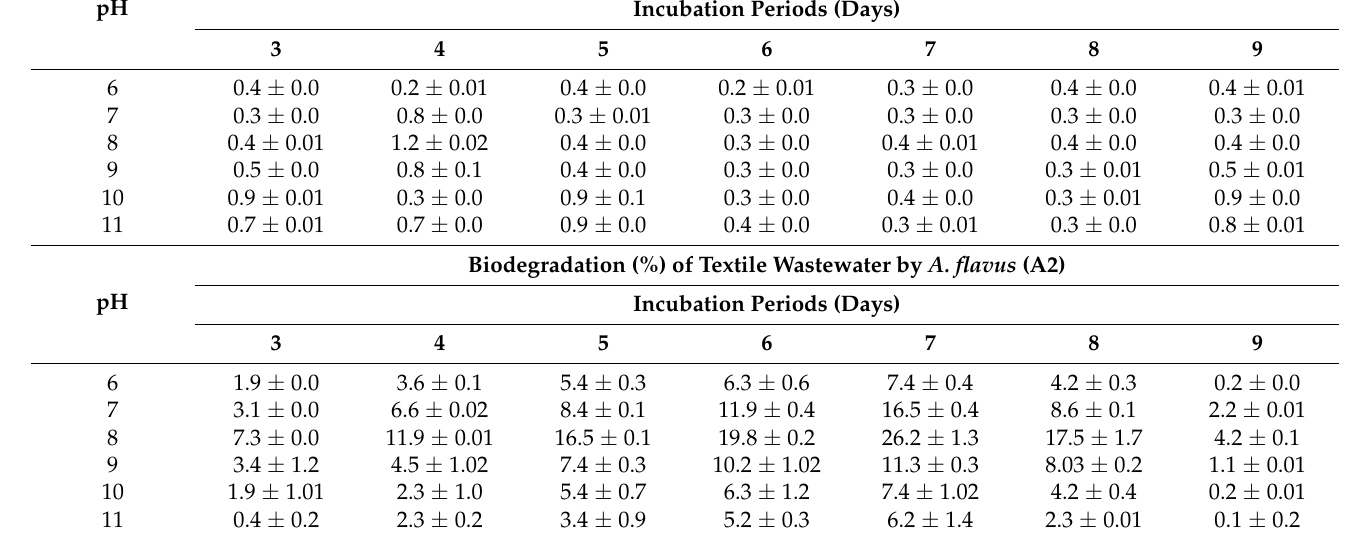
Figure 2. Phylogenetic tree of ITS sequences of the fungal isolates A2 and G2-1 with the sequences from NCBI and designated as Aspergillus flavus A2 and Fusarium oxysporum G2-1. 3.2. Effect of Different Incubation Periods and pH Values on Dye Decolorization Percentages Table 1. Effect of different pH values on decolorization of textile wastewater by A. flavus (A2), F. oxysporum (G2-1), and without fungal inoculation (Ctrl) after different incubation periods, means ± SE ( n = 3). Biodegradation (%) of Textile Wastewater without Fungal Inoculation (Ctrl) pH Incubation Periods